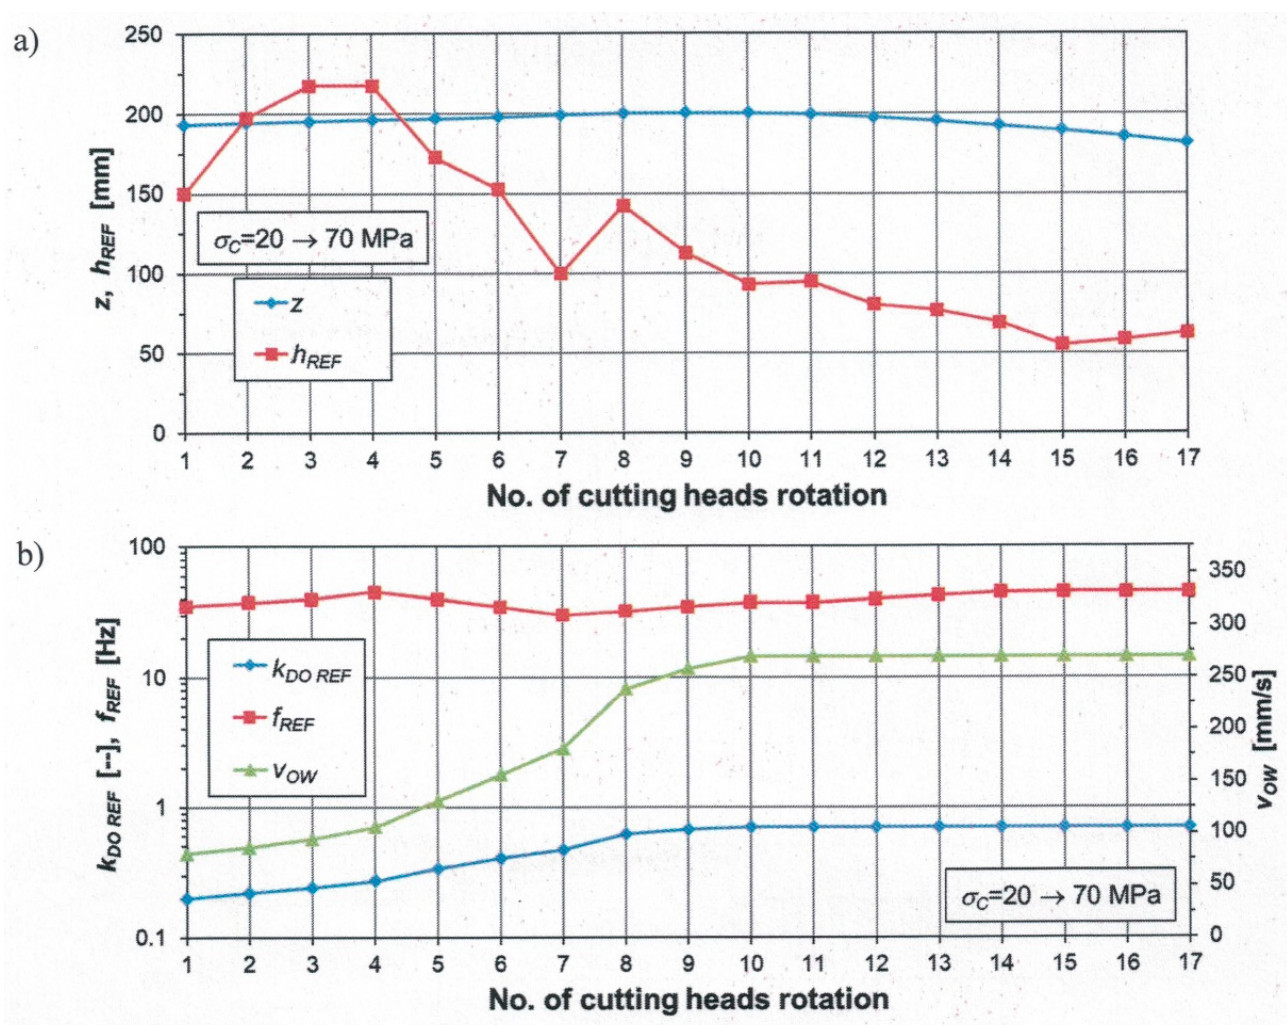
Figure 13. The course of cutting parameters: ( a ) web of cut ( z ) and set cut height ( h REF ) and ( b ) cutting heads movement speed ( v OW ), and set values: supply voltage frequency ( f REF ) and electrohydraulic valve opening coefficient ( k DO REF ) in subsequent rotations of the cutting heads during the performance of lower cut in the automatic control mode in rocks with increasing uniaxial compressive strength.